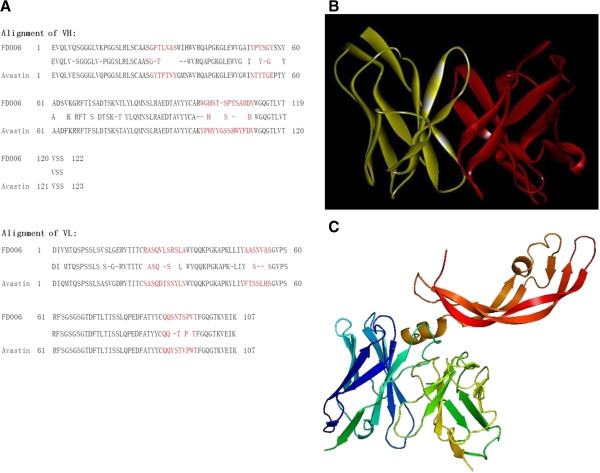
Theoretical analysis of FD006 to bind VEGF. A: The amino acid residues and CDR region classification of FD006 (versus Avastin/bevacizumab); B: The 3-D structure of variable region in FD006 using computer-guided homology modeling and molecular dynamics methods. The yellow ribbon denoted the light chain variable region and the red ribbon denoted the heavy chain variable region; C: The 3-D complex structure of FD006 variable region and VEGFA obtained from computer-guided molecular docking and dynamics methods. The upper red ribbon denoted VEGF, the lower left (blue) ribbon was FD006-VL and the lower right (green and yellow) denoted FD006-VH.